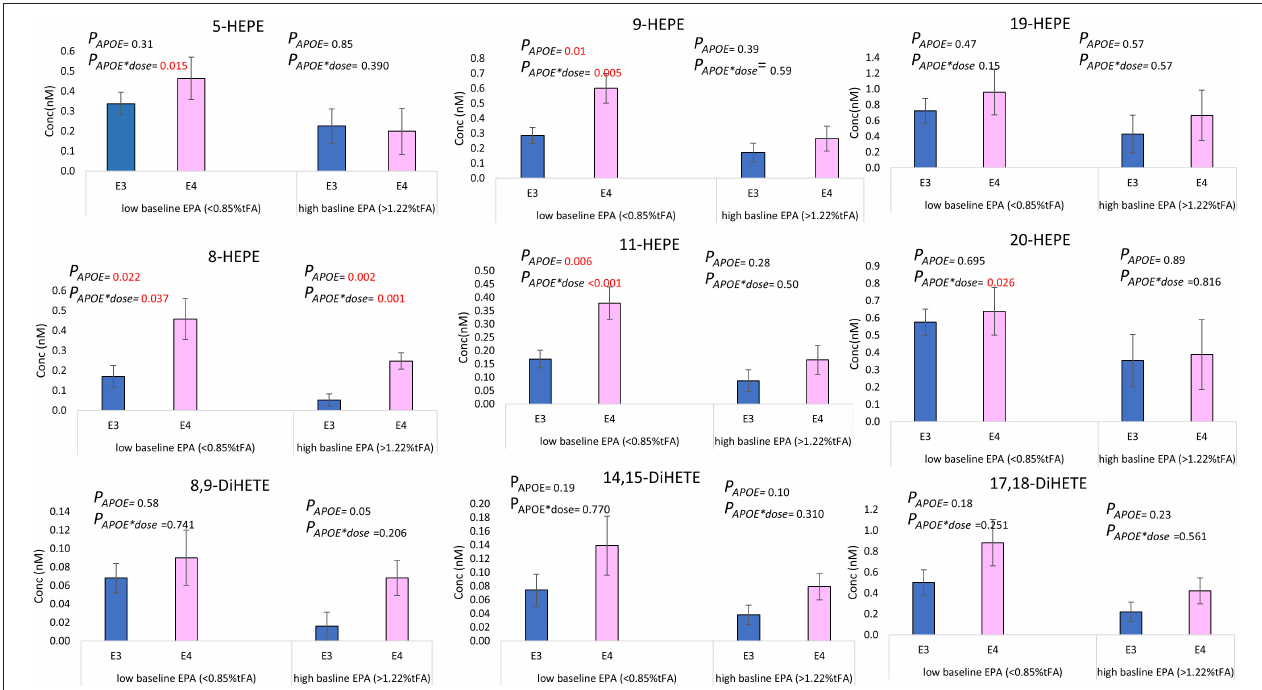
FIGURE 5 | Mean absolute change ( ± SEM) in select EPA-derived oxylipins (nM) at 12 months of supplementation, according to APOE genotype and the level of baseline EPA. Low basal EPA ( APOE3 n = 22, APOE4 n = 9), high basal EPA ( APOE3 n = 18, APOE4 n =